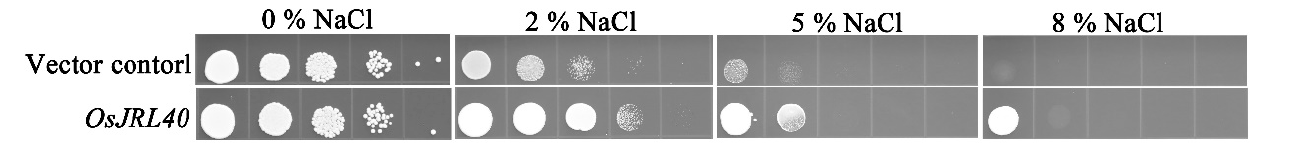
Figure 8. Comparison of the salt tolerance phenotypes of yeast BY4741 cells expressing OsJRL40 or the empty pYES2 vector control. Ten-fold serial dilutions of yeast cultures were spotted onto plates containing various concentrations of NaCl and incubated at 30 °C. Pictures were taken after 7 days.